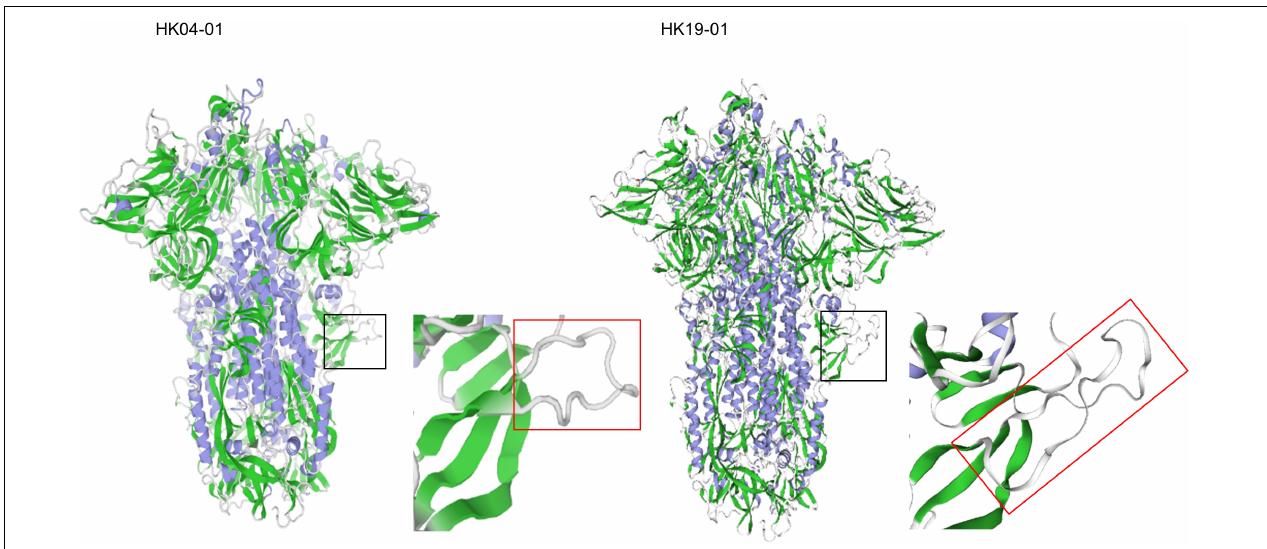
FIGURE 4 | Structure of the HCoV-OC43 spike glycoprotein trimer predicted by SWISS-MODEL homology modeling. Models were generated using the structure of HCoV-OC43 (Protein Data Bank code 6NZK). The black square zone is magnified, and the red rectangle shows loop containing the S1/S2 furin protease cleavage site (aa residues 756–772). The left and right panel represents HCoV-OC43 HK04-01 and HK19-01,